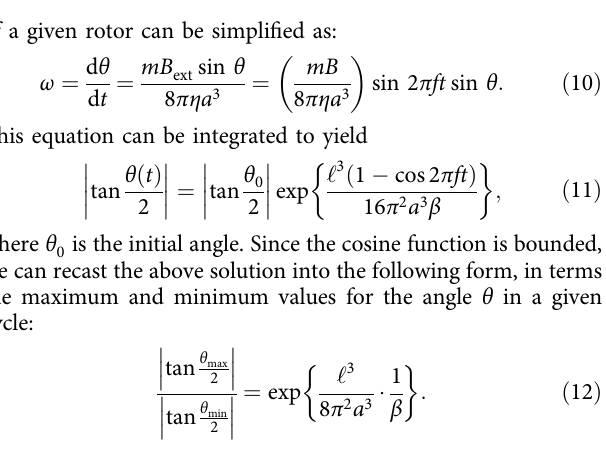
Fig. 4 Generated fl ow fi elds and fl uid mixing using the quarter and staggered patterns. a Generated fl ow fi eld as a function of the external fi eld direction ϕ for α ¼ 10 : 0 and β ¼ 0 : 05. Streamline colours represent the vortex strength. b Tracer particle positions after 50 cycles of the external fi eld actuation. c Phase diagram from the simulation in N x ¼ N y ¼ 4 array. Vertical dotted line shows the theoretical prediction of critical value α ¼ ‘ 3 = ð 8 π 3 a 3 Þ . d – f Rotational patterns under three different conditions; red denotes counter-clockwise rotation, while blue dotted line shows the value β s denotes clockwise rotation. Bottom row shows generated fl ow fi eld from the rotational